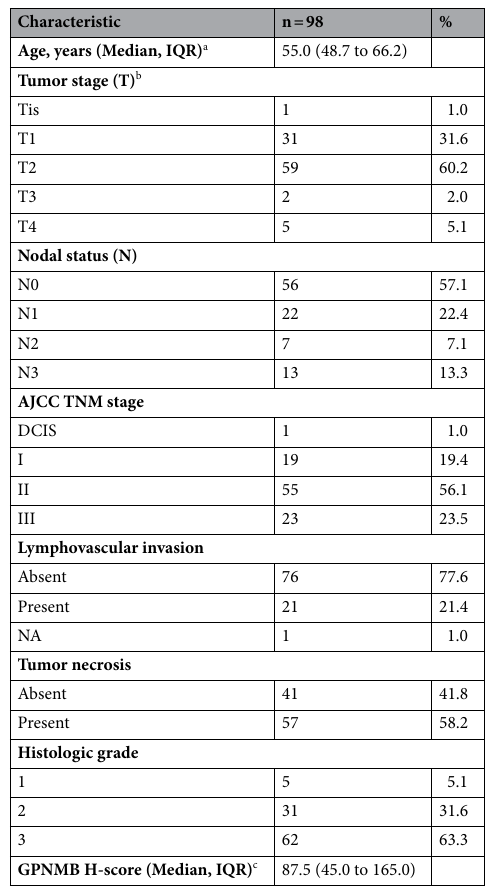
Table 1. General characteristics of 98 patients with triple-negative breast cancer (TNBC). a IQR, Interquartile range; DCIS, Ductal carcinoma in situ. b Stage was according to 7th edition of AJCC staging 56 . c Data were expressed as H-score, as described in Method